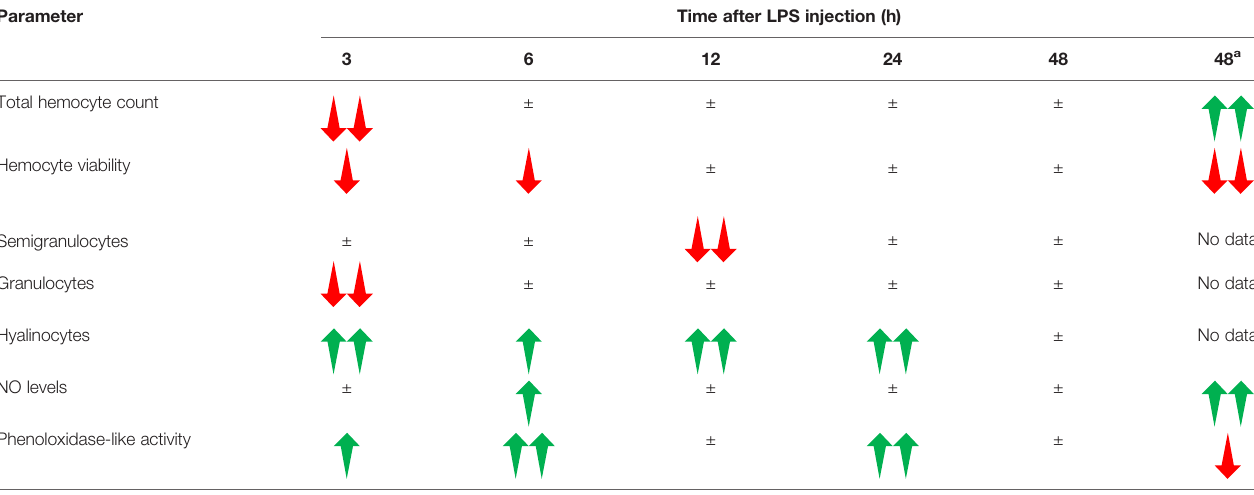
a Mayall et al. (20); data for P. scaber 48 h after injection with a higher dose of LPS (50 µg/µL). a Arrows ( ↑ / ↓ ; ↑↑ / ↓↓ ) indicate statistically signi fi cant changes (p <0.05; p <0.01) in the measured immune parameters, while ± indicates no signi fi cant changes compared to the trauma control